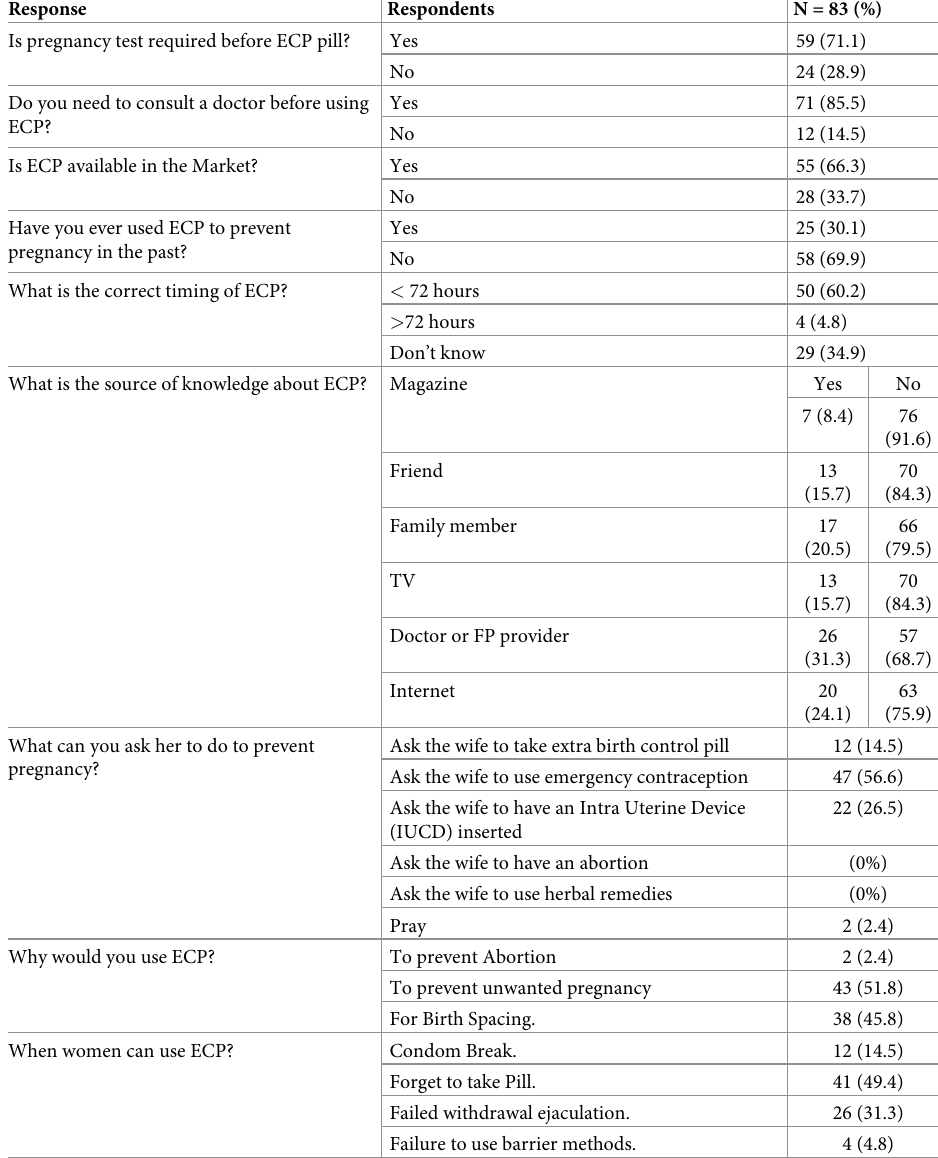
Table 3. Knowledge of participants about EC among men (N =